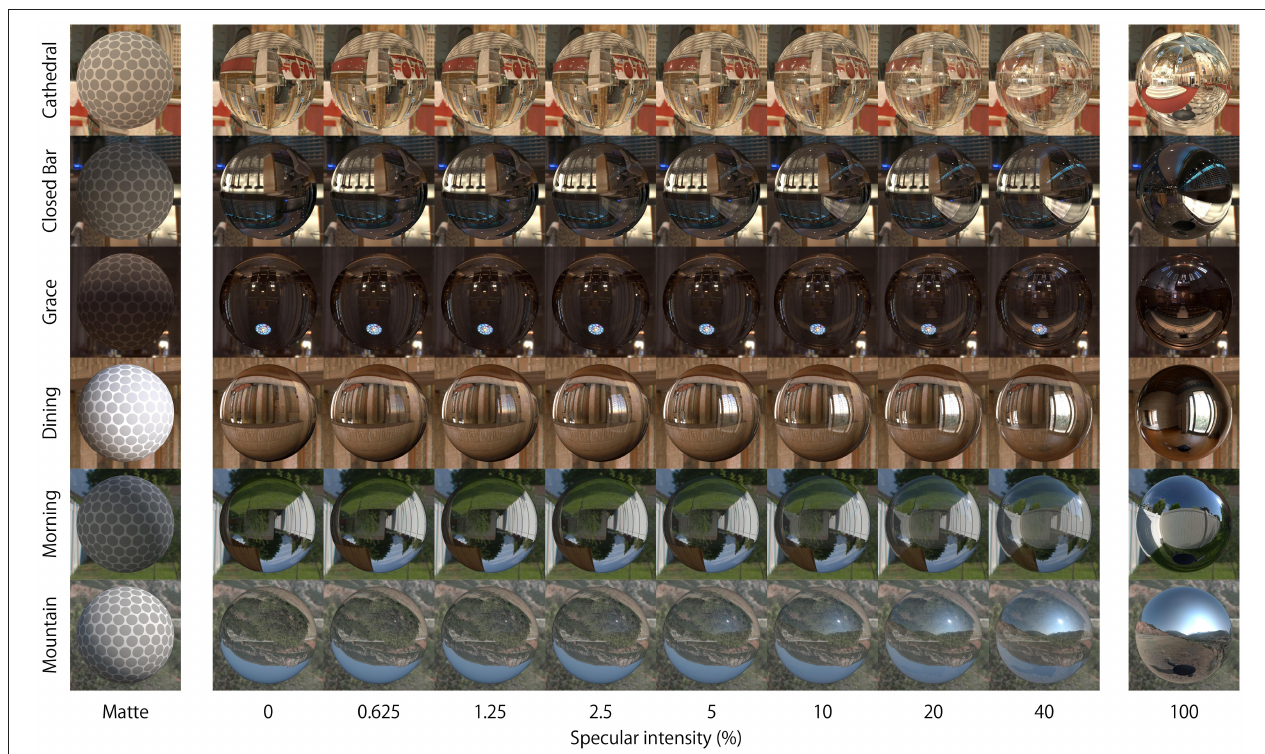
FIGURE 2 | Appearance of stimuli. Matte and Test objects (specular ratio: 0–40%) were used in the experiment with six light probes. The 100% specular surface was not used in the experiment.